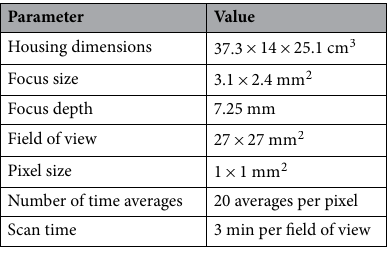
Table 1. THz scanner performance